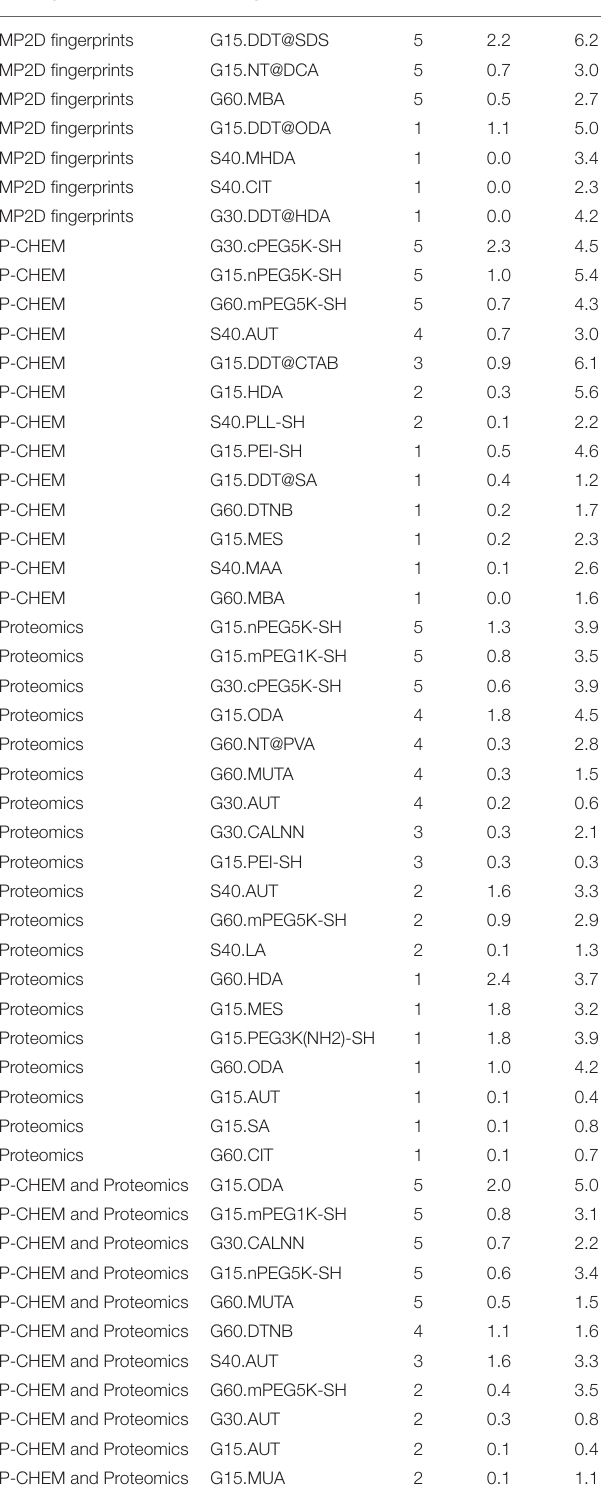
TABLE 2 | P-CHEM properties of the Protein corona dataset measured with and without human serum. Property Medium